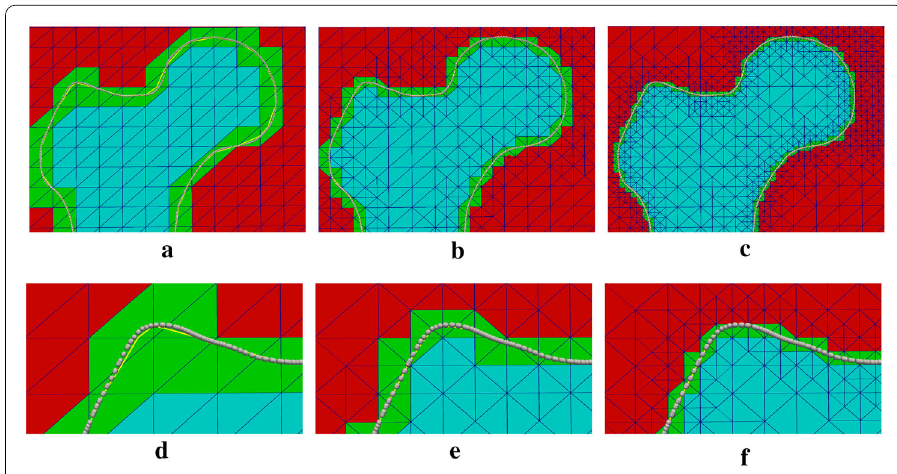
Fig. 7 Linear approximation of the femur bone surface triangulation in regular background mesh for two refinement steps in a slice through the femur head ( a – c ) and a zoom to the area of high curvature in the femur bone slice ( d – f ). For the coarsest mesh, we observe a clear difference between the piecewise linear approximation of the level set function and the surface triangulation in the area of high curvature. This difference is resolved by mesh